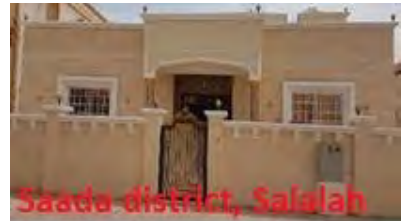
Figure 24. Fac¸ade’s photograph building